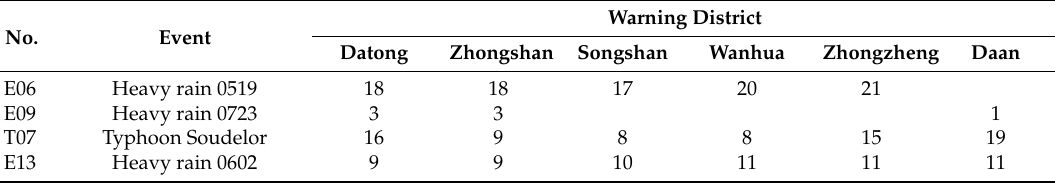
Table 11. The hydrodynamic modeling output for each event’s start time of manhole flooding after the onset of rainfall for the six districts.